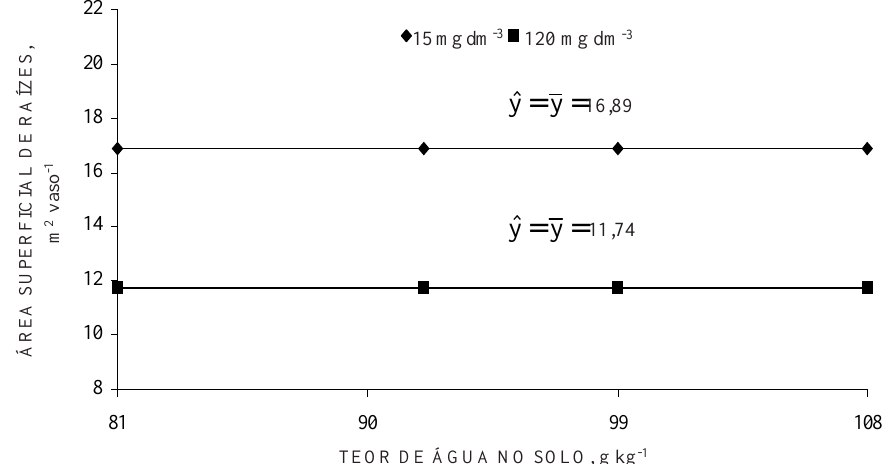
Figura 7. Área superficial das raízes do milheto (28 DAE), considerando os teores de água no solo, correspondentes aos potenciais testados, e as doses de potássio. Símbolos = valores observados; linha = valores